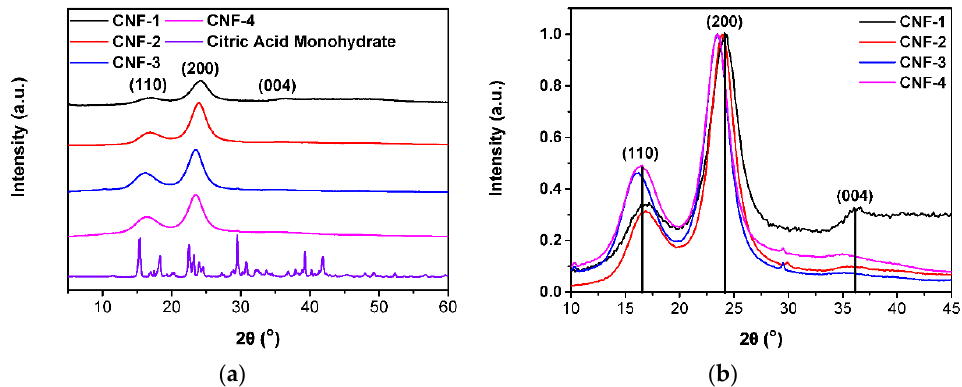
Figure 3. ( a ) Smoothed X-ray diffractometry patterns of CNF membranes and citric acid monohydrate samples. ( b ) Peaks corresponding to cellulose characteristic lattice planes (110), (200), and (004) are indicated in the overlaid diffraction patterns.